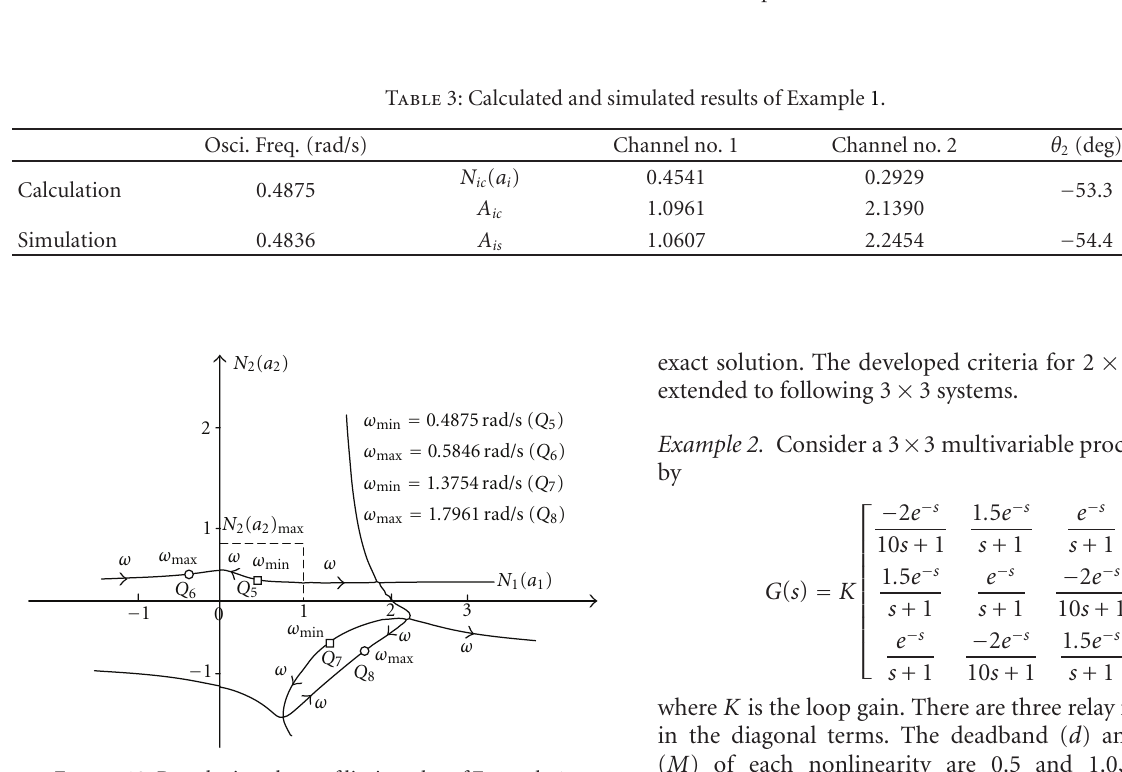
Figure 10: Root loci analyses of limit cycles of Example 1.